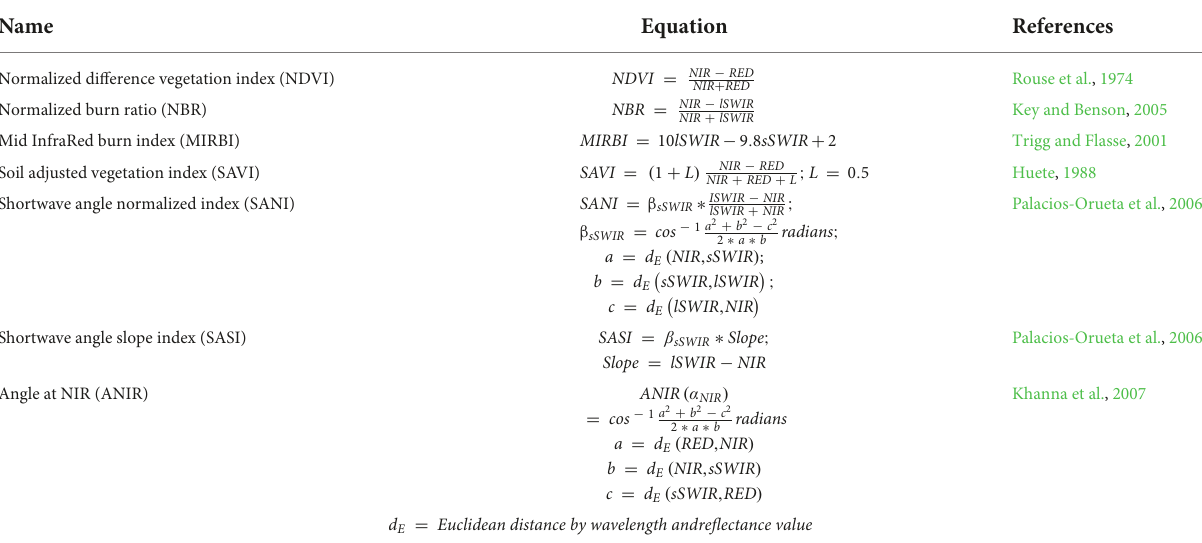
TABLE 1 Equations of spectral indices that were calculated in this